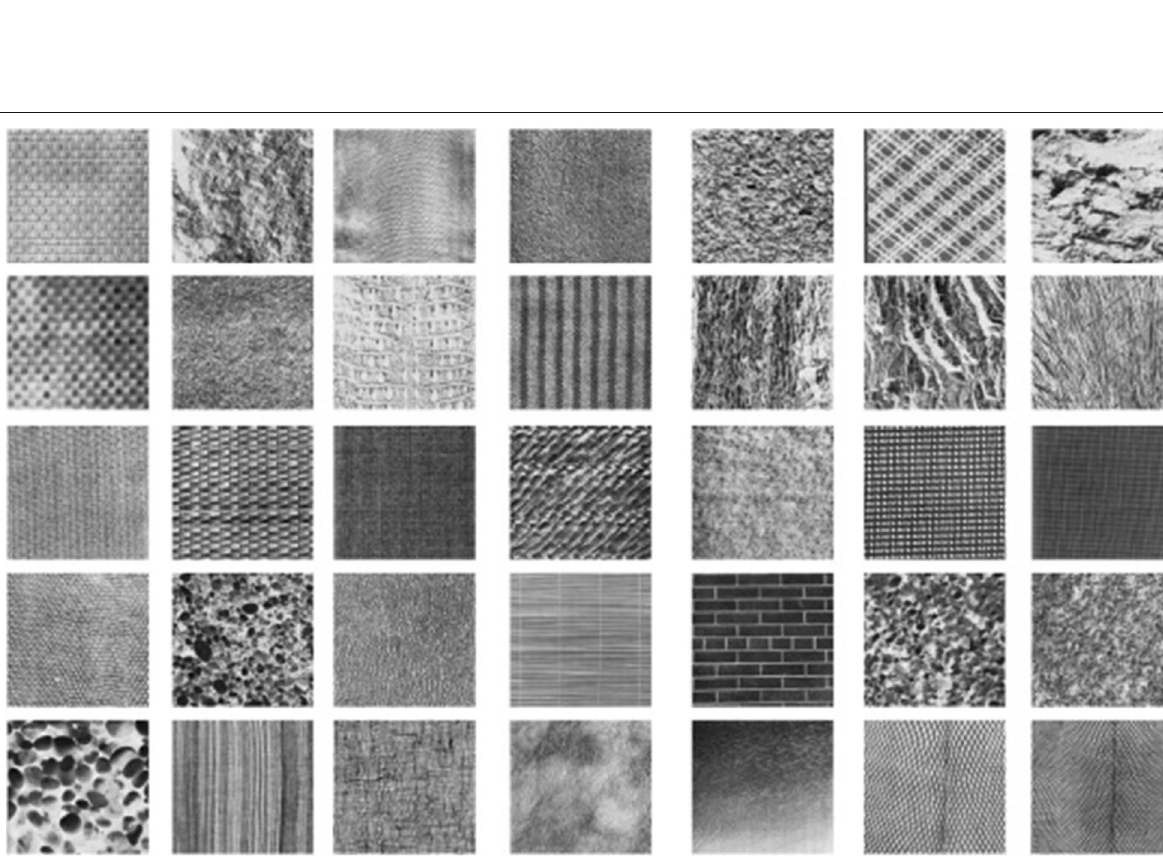
Fig. 19 Some sample images in Brodatz image